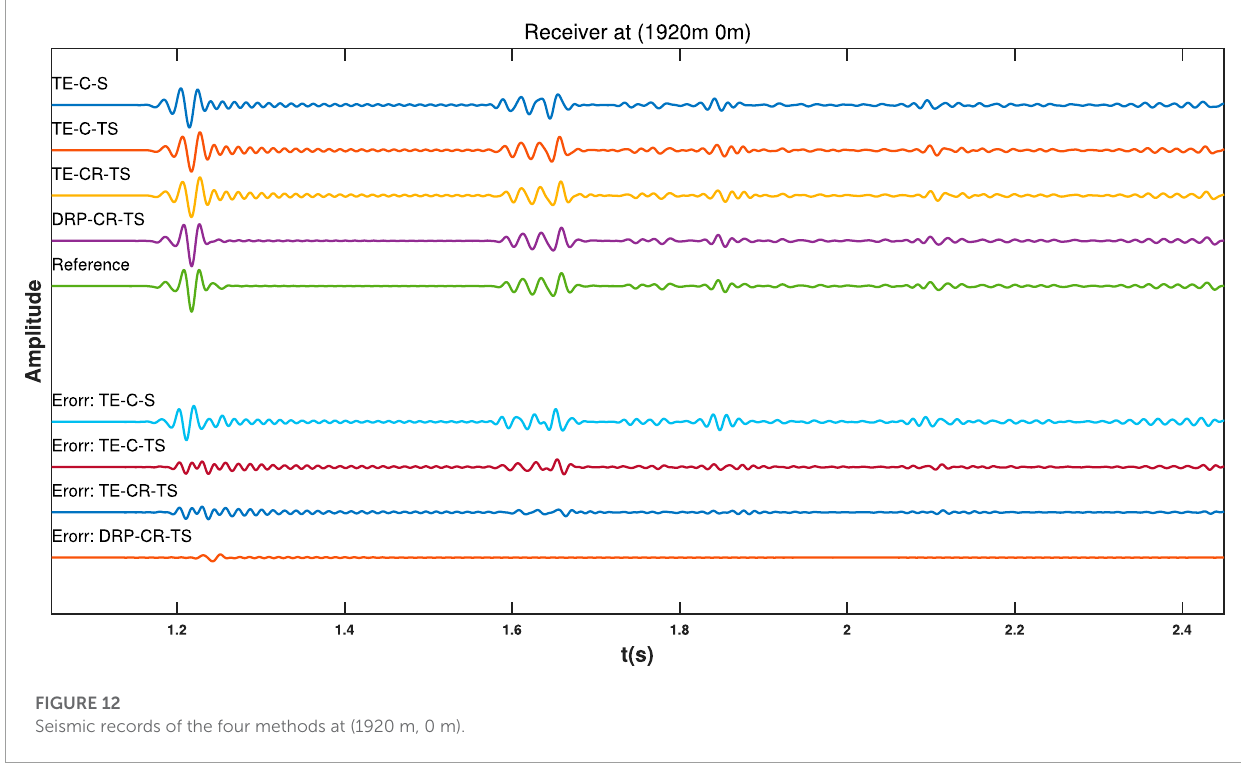
40 Hz is located at the spatial point ( 1536 m , 1536 m ) . Two